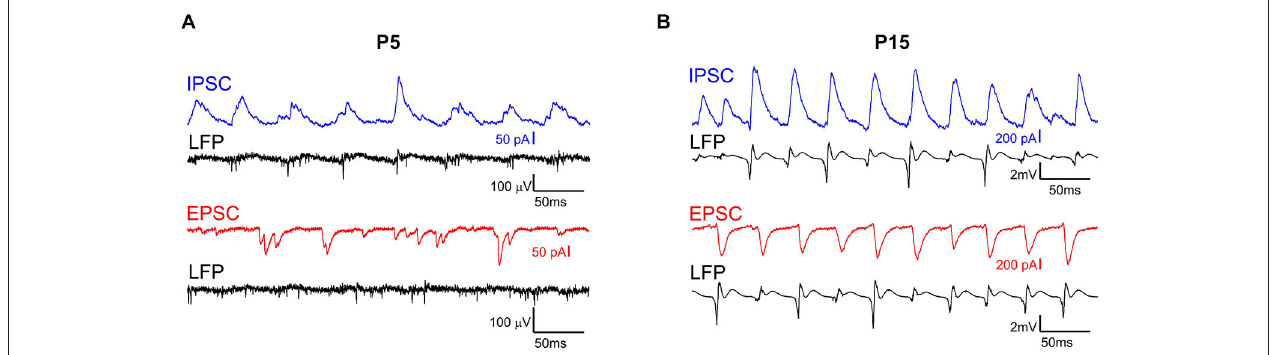
− 50 mV (red) in hippocampal slices prepared from P5 (A) and P15 (B) rats in the presence of 300 nM—kainate. Below are shown simultaneous LFP recordings (black) from CA3 pyramidal cell layer in vicinity of the patched cell.